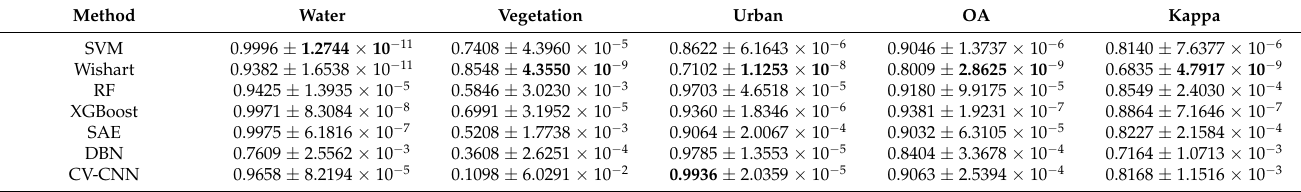
Table 2. Classification Results of San Francisco with Different Methods, where the highest mean and lowest variance for each category are marked in